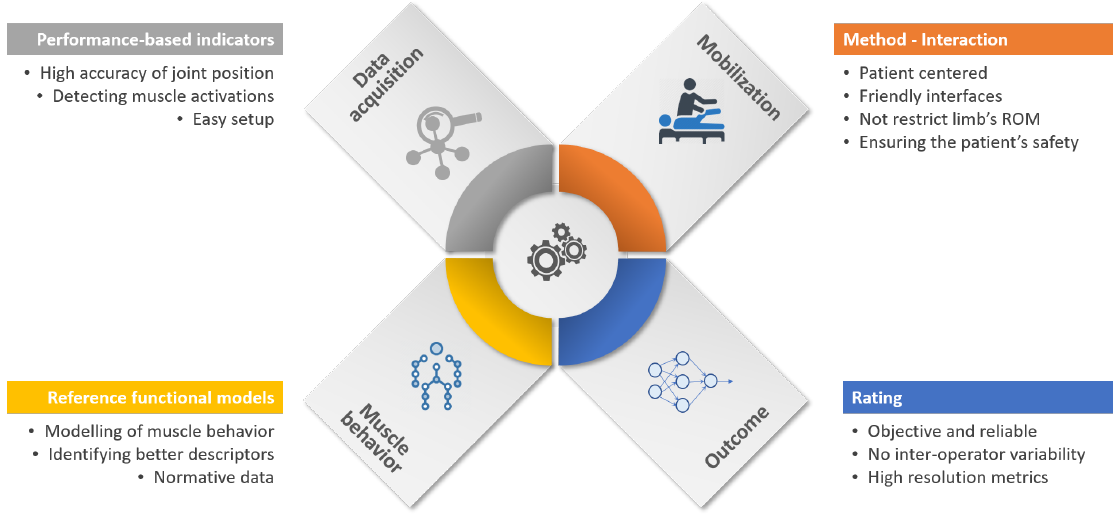
Figure 3. Essential components for robot-aided assessment of upper limb (UL)